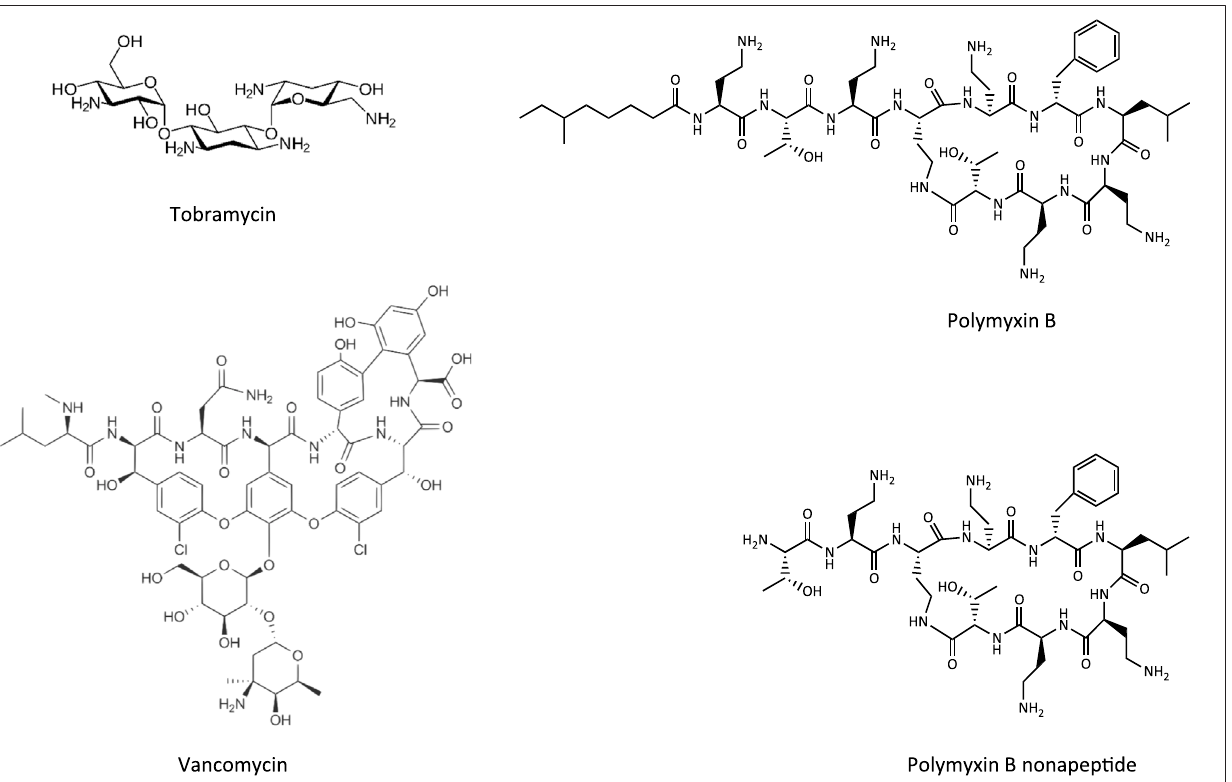
FIGURE 4 | Chemical structures of tobramycin as an example of an aminoglycoside, vancomycin as a glycopeptide, and polymyxin B and its less toxic analogue polymyxin B nonapeptide.